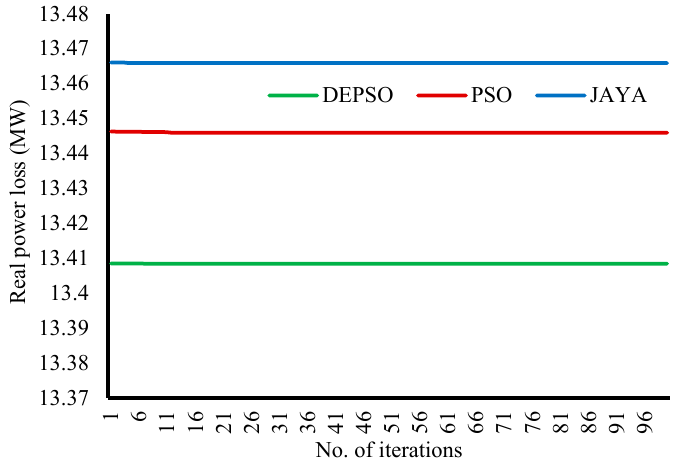
Figure 4. Convergence plot for IEEE 14-bus system.